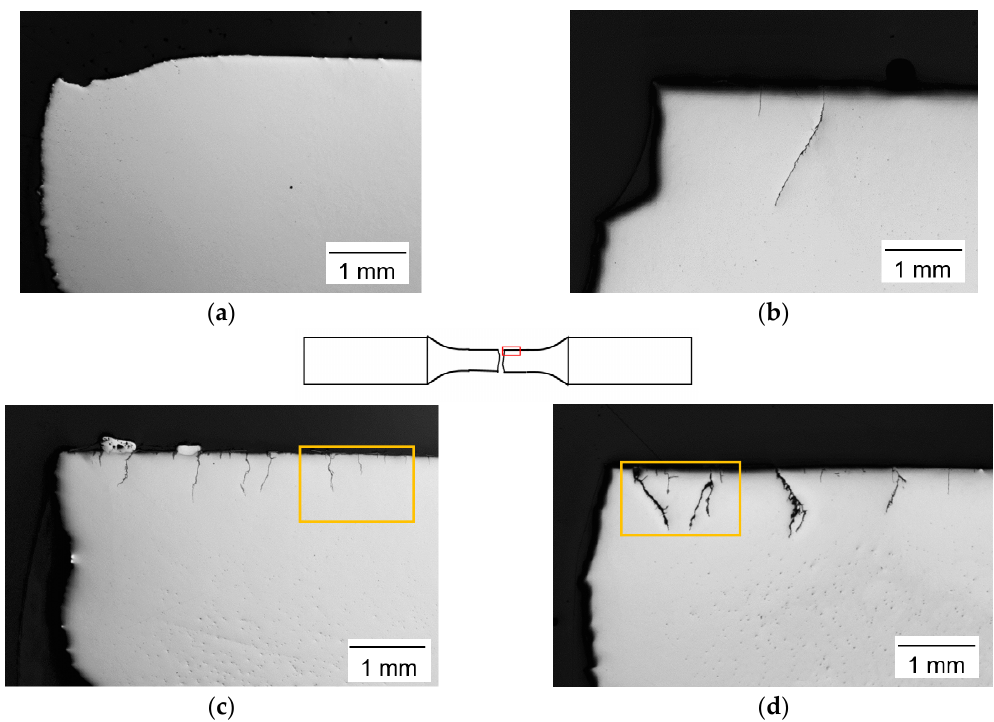
Figure 17. Optical micrograph of the longitudinal sections for the different total strain ranges at 620 °C ( a ) LCF ±0.2%, ( b ) LCF ±0.5%, ( c ) RF ±0.2%, and ( d ) RF ±0.4%. Fracture surfaces are left. Yellow rectangles indicate the regions which are shown in a higher magnification in Figure 18a,b.